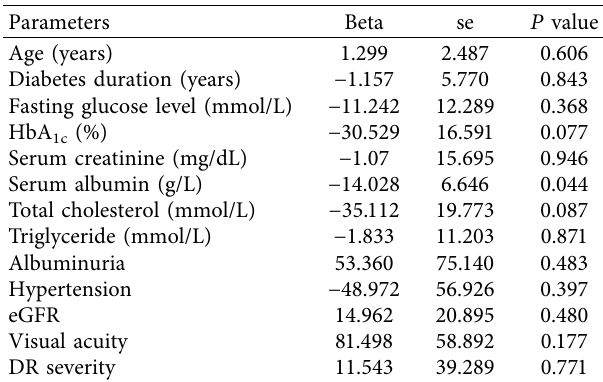
Table 3: Univariate linear regression for correlating factors of subretinal fuid